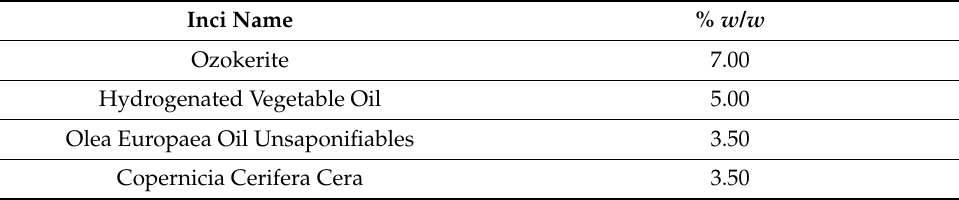
Table 10. Selected wax blend.